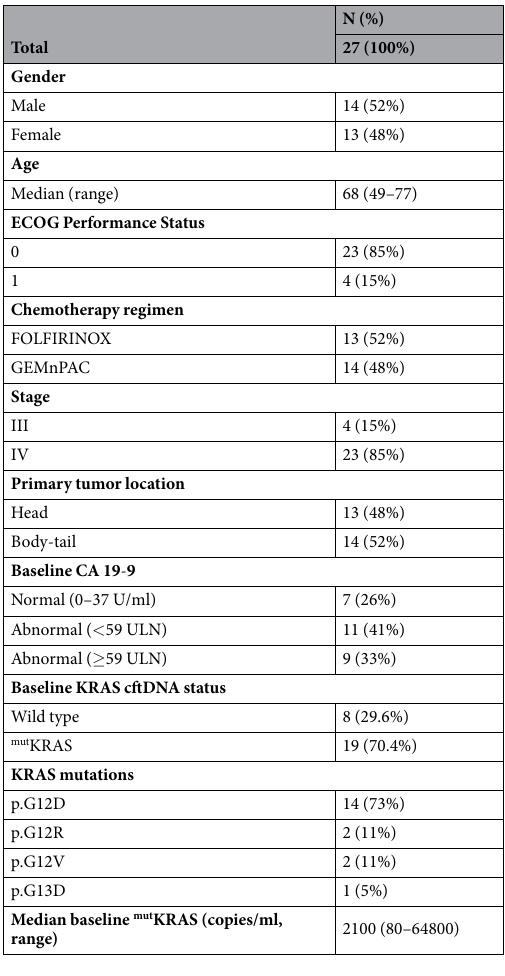
Table 1. Characteristics of